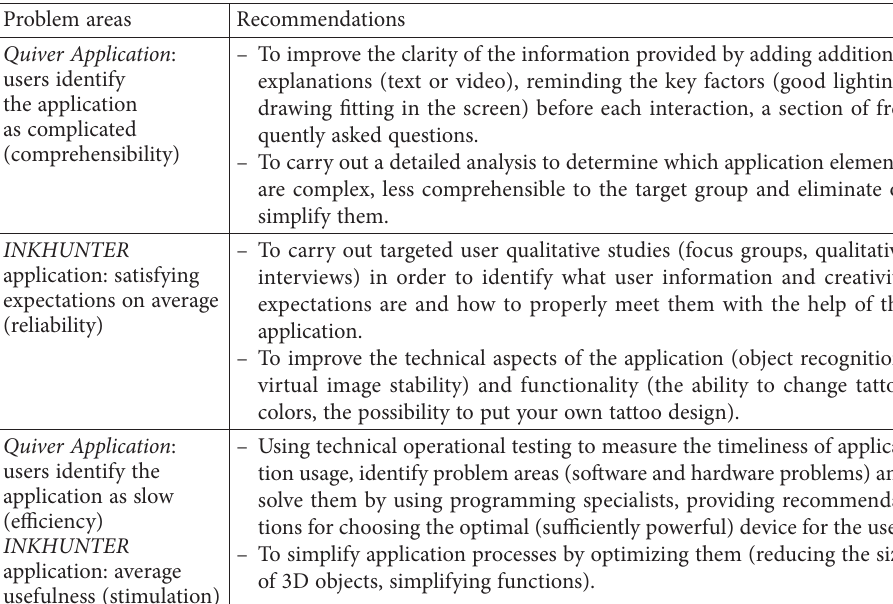
Table 3. Recommendations for improving Quiver Application and INKHUNTER application (source: created by the authors) Problem